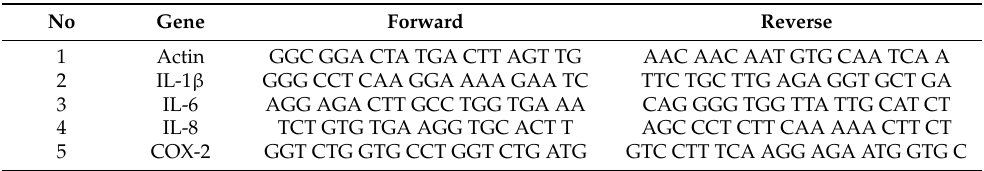
Table 1. Sequences of PCR primers of IL-1 β , IL-6, IL-8, COX-2, and a housekeeping gene,